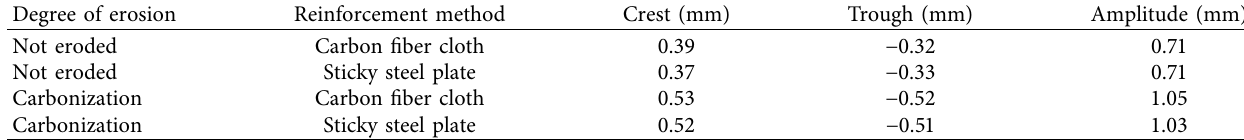
Table 15: Trend of dynamic displacement of test plates under 2 million fatigue cycles.